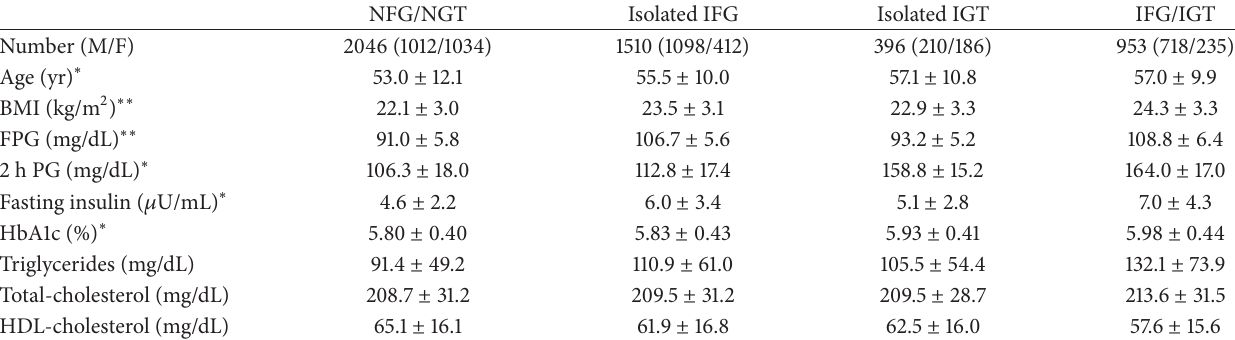
Table 1: Clinical characteristics of